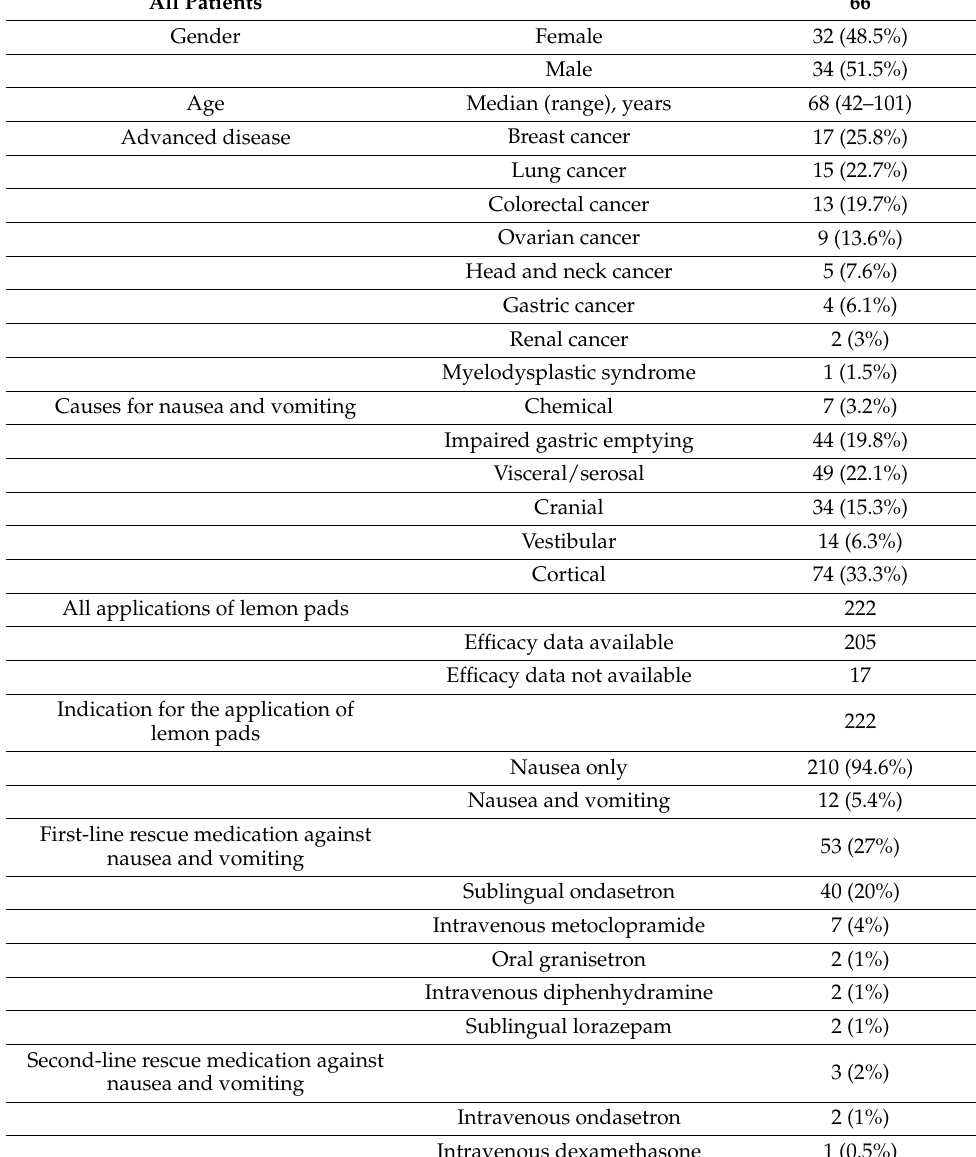
Table 1. Patients’ ( n = 66) characteristics and descriptions of lemon pad applications ( n = 222). All